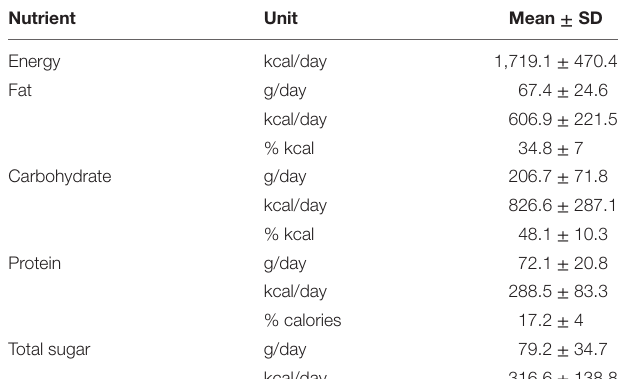
Table 2 | Results from 24 h dietary recalls: average energy, fat, carbohydrate, protein, total sugar, and added sugar intake ( n = 22).